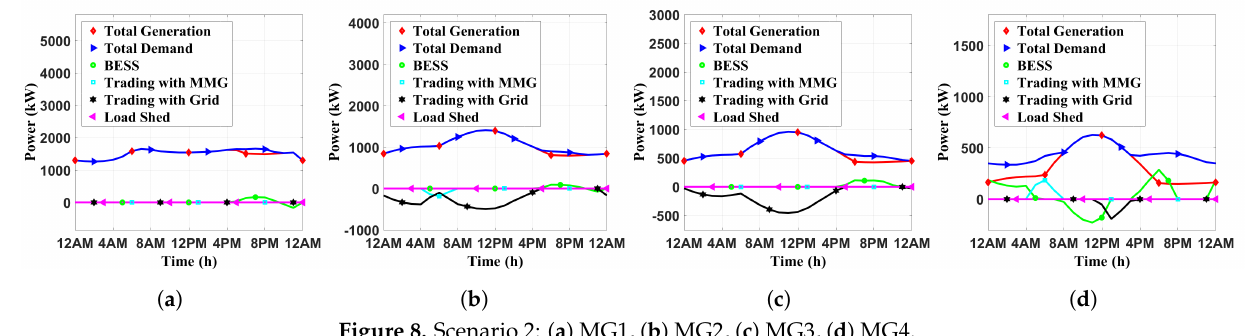
Figure 8. Scenario 2: ( a ) MG1, ( b ) MG2, ( c ) MG3, ( d )